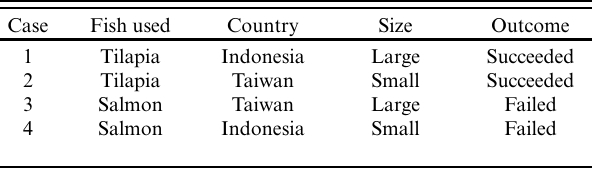
Table 2 . Sample data for a qualitative comparison.